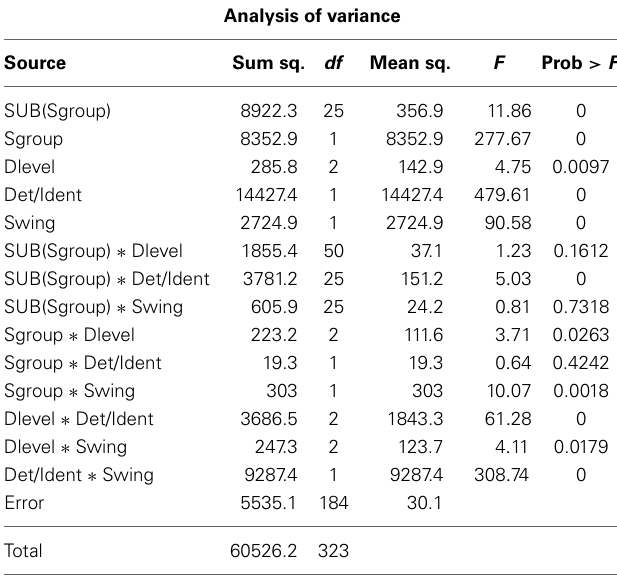
Table 2 | ANOVA of data from detection vs. identification